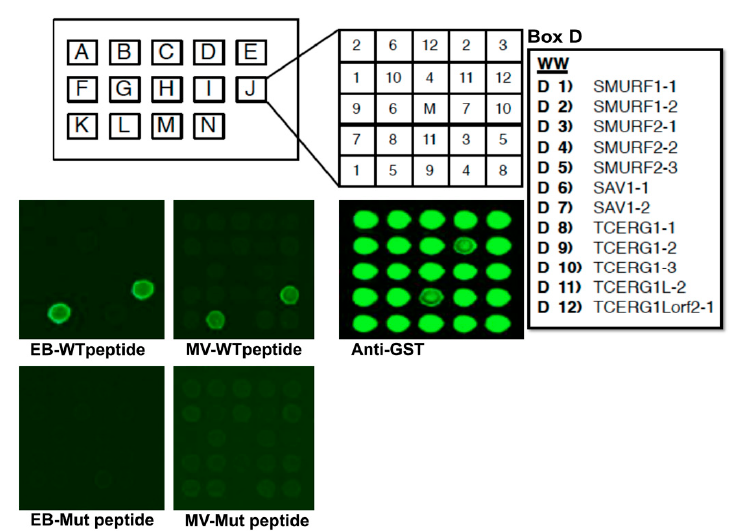
Figure 1. WW domain array screen. Purified GST/WW domain fusion proteins were arrayed in duplicate in Boxes A–N in numbered squares 1–12 as shown. The GST/WW domain fusion proteins present in Box D are shown. The array was screened with the following biotin-labeled peptides: EB-WT (MRRVILPTAPPEYMEAI-K-biotin), EB-Mut (MRRVILPTAAAEAMEAI-K-biotin), MV-WT (MQYLNPPPYADHGGANQL-K-biotin), or MV-Mut (MQYLNAAPAADHGANQL-K-biotin). A positive interaction was observed between SMURF2-3 (position #5) and both EB-WT and MV-WT peptides. An anti-GST control for protein expression is shown. The center M square contains GST alone.